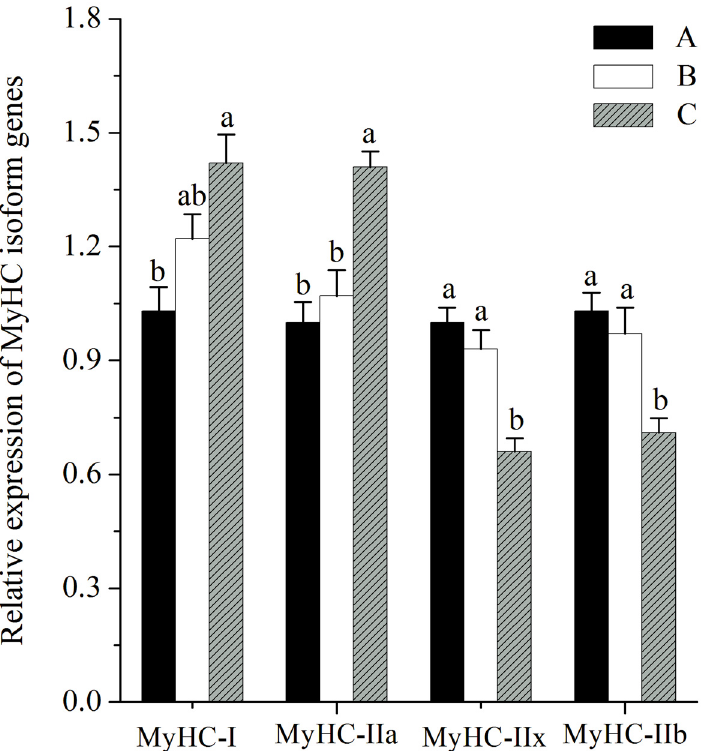
Fig 1. Relative mRNA expression of myosin heavy-chain (MyHC) isoform genes in LL muscles. Diet A contained 44.1% starch, diet B contained 37.6% starch and diet C contained 30.9% starch. mRNA expression was normalized to 18s rRNA gene expression. Data were shown as the mean ± standard error of eight replicates. a,b Mean values within different letters were significantly different ( P < 0.05).